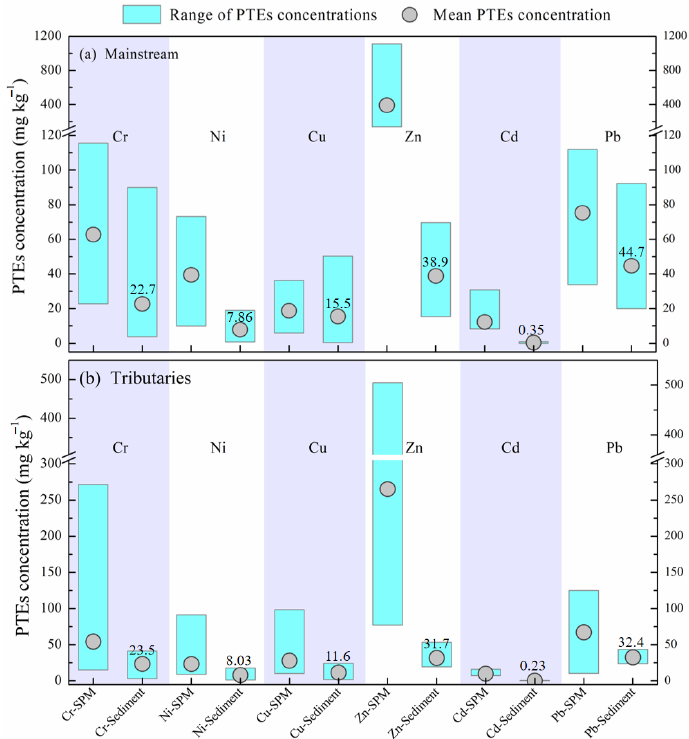
Figure 5. PTEs concentration between SPM and sediment in the Jiulongjiang River, ( a ) Mainstream (Beixi River), ( b ) Tributaries (Xixi and Nanxi River). Sediment data are from [24] .